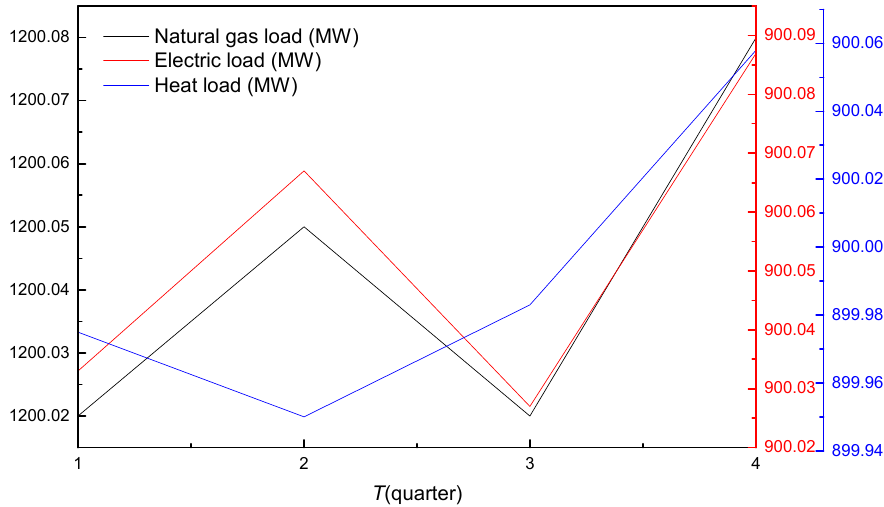
Figure 10. Quarterly load change.